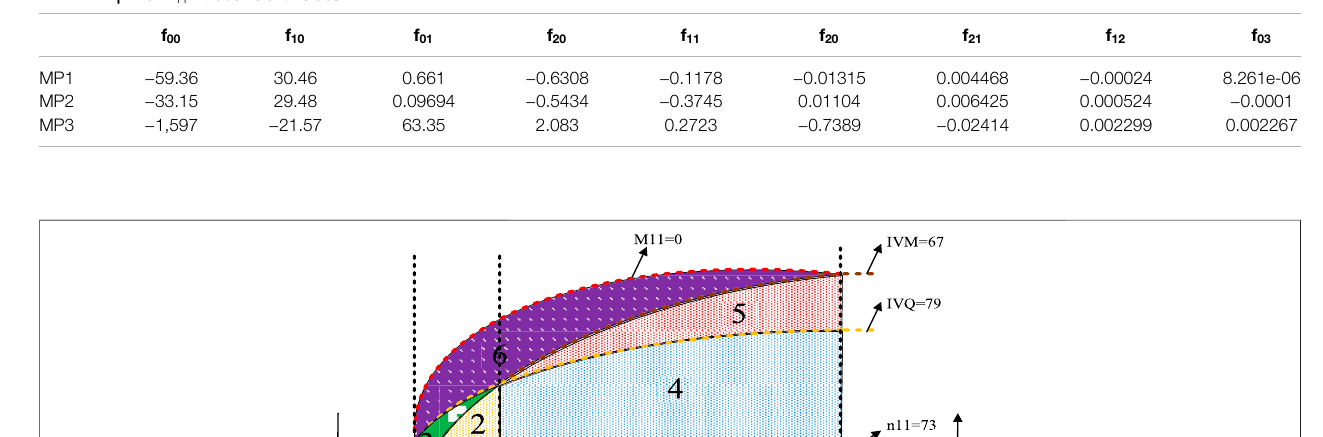
TABLE 2 | The M 11 fi t coef fi cient values.